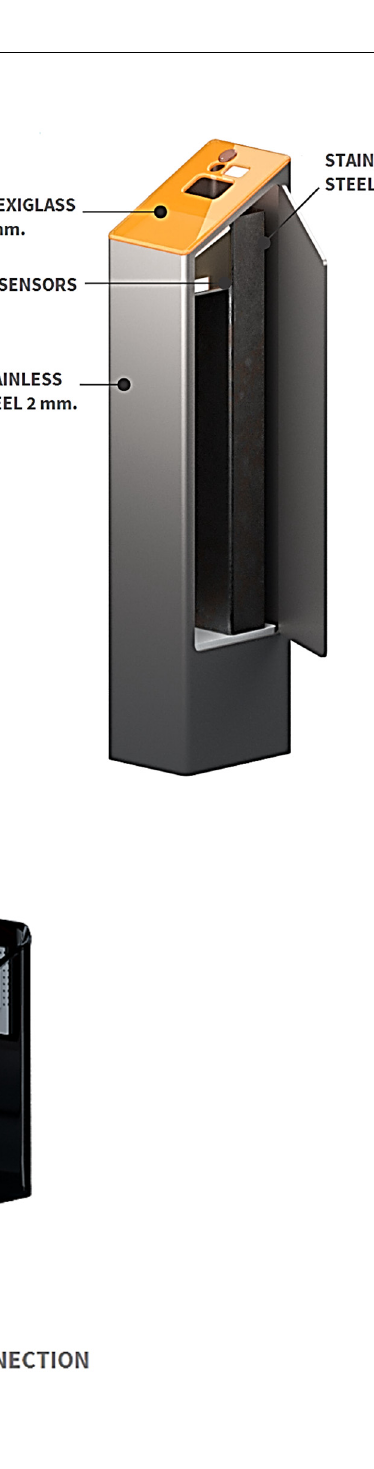
Figure 16. CAD 3D model.